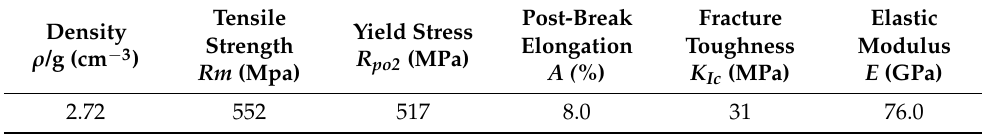
Table 2. Mechanical characteristics of the 2195 alloy.